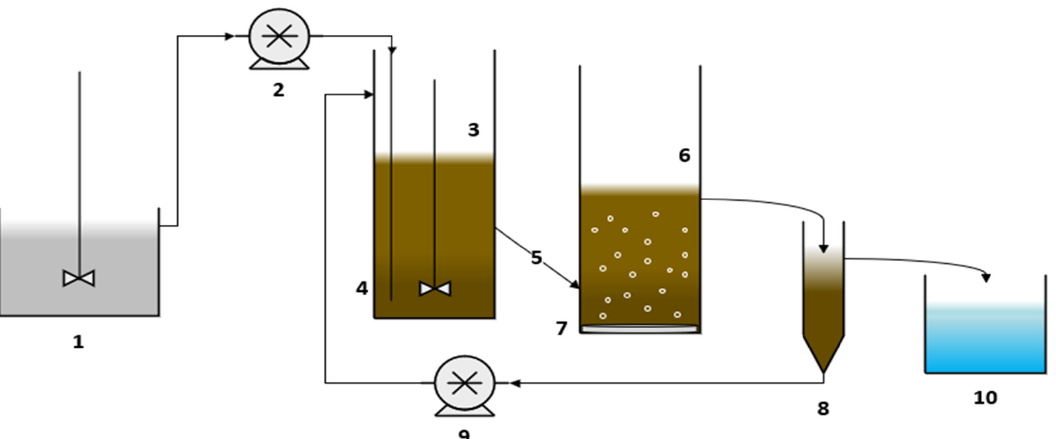
Figure 1. Schematic figure of the lab-sale CFR system. 1—Feed reservoir; 2—Feeding pump; 3—Anaerobic reactor; 4—Bottom feeding; 5—Connecting pipe between reactors; 6—Aerobic reactor; 7—Air diffusor; 8—Clarifier; 9—Recycling pump; and 10—Treated effluent tank.